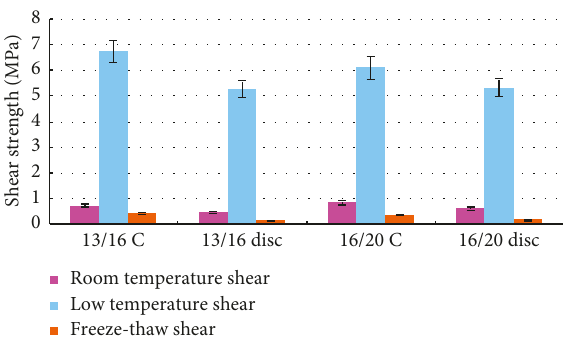
Figure 14: Comparison of gradation.